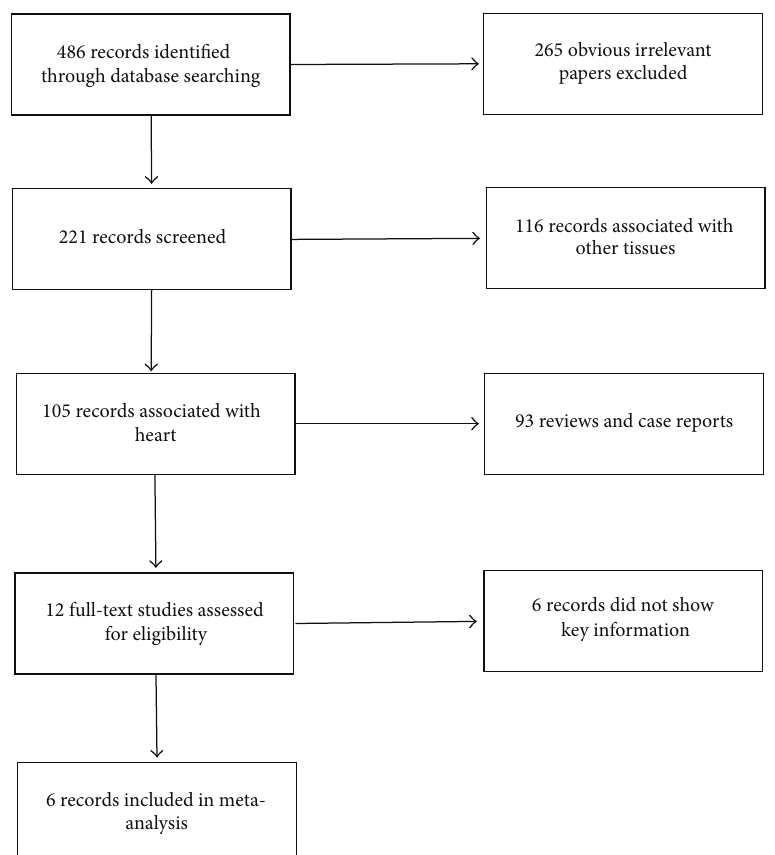
Figure 1: Results of systematic search of the